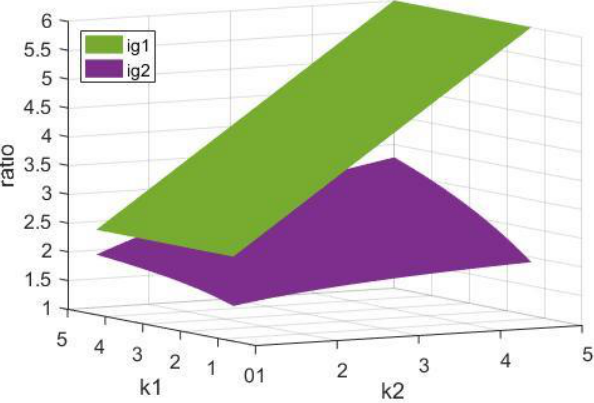
Figure 10. The available values of i g 1 and i g 2 .